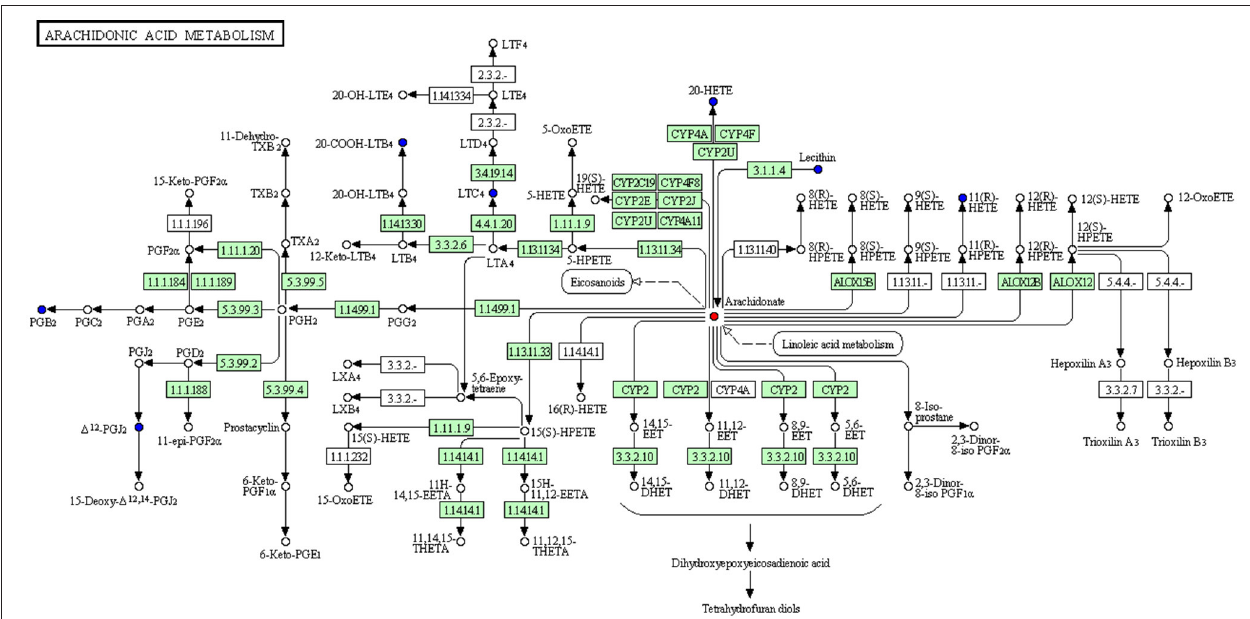
FIGURE 8 | Metabolism-Protein Networks. Related proteins in Arachidonic acid metabolism